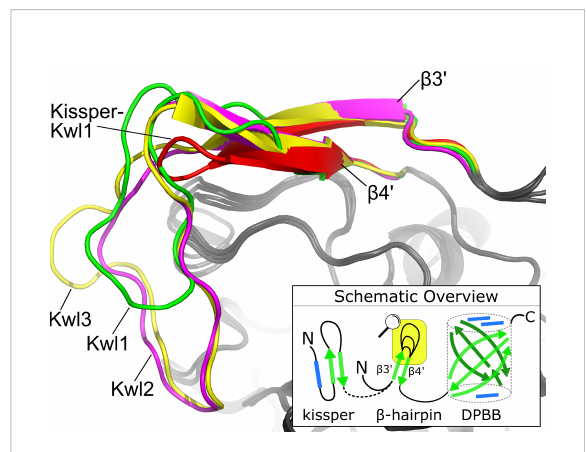
FIGURE 4 The consensus structure of the loop connecting b 3 ′ and b 4 ′ in the b -hairpin. The Kiwellin-groups are highlighted by different colors: red: Kissper-Kwl1, green: Kwl1, magenta: Kwl2, yellow: Kwl3. The bottom right: a schematic overview of (Kissper-) Kiwellins. Green arrow: b -sheet, blue rectangle: a -helix, yellow box: zoomed